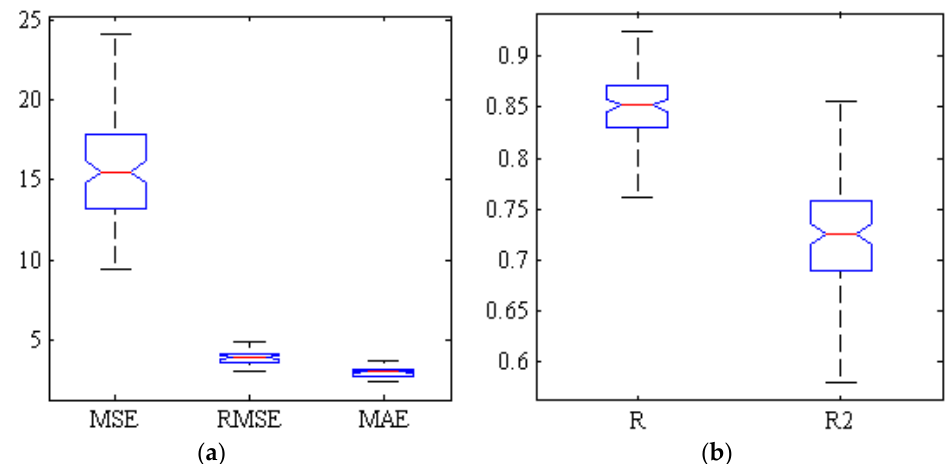
Figure 8. Correlation analysis of scatter plot between mean estimated and measured taste index of Gala apple by PLSR method based on spectral data related to key wavelengths in 300 iterations.